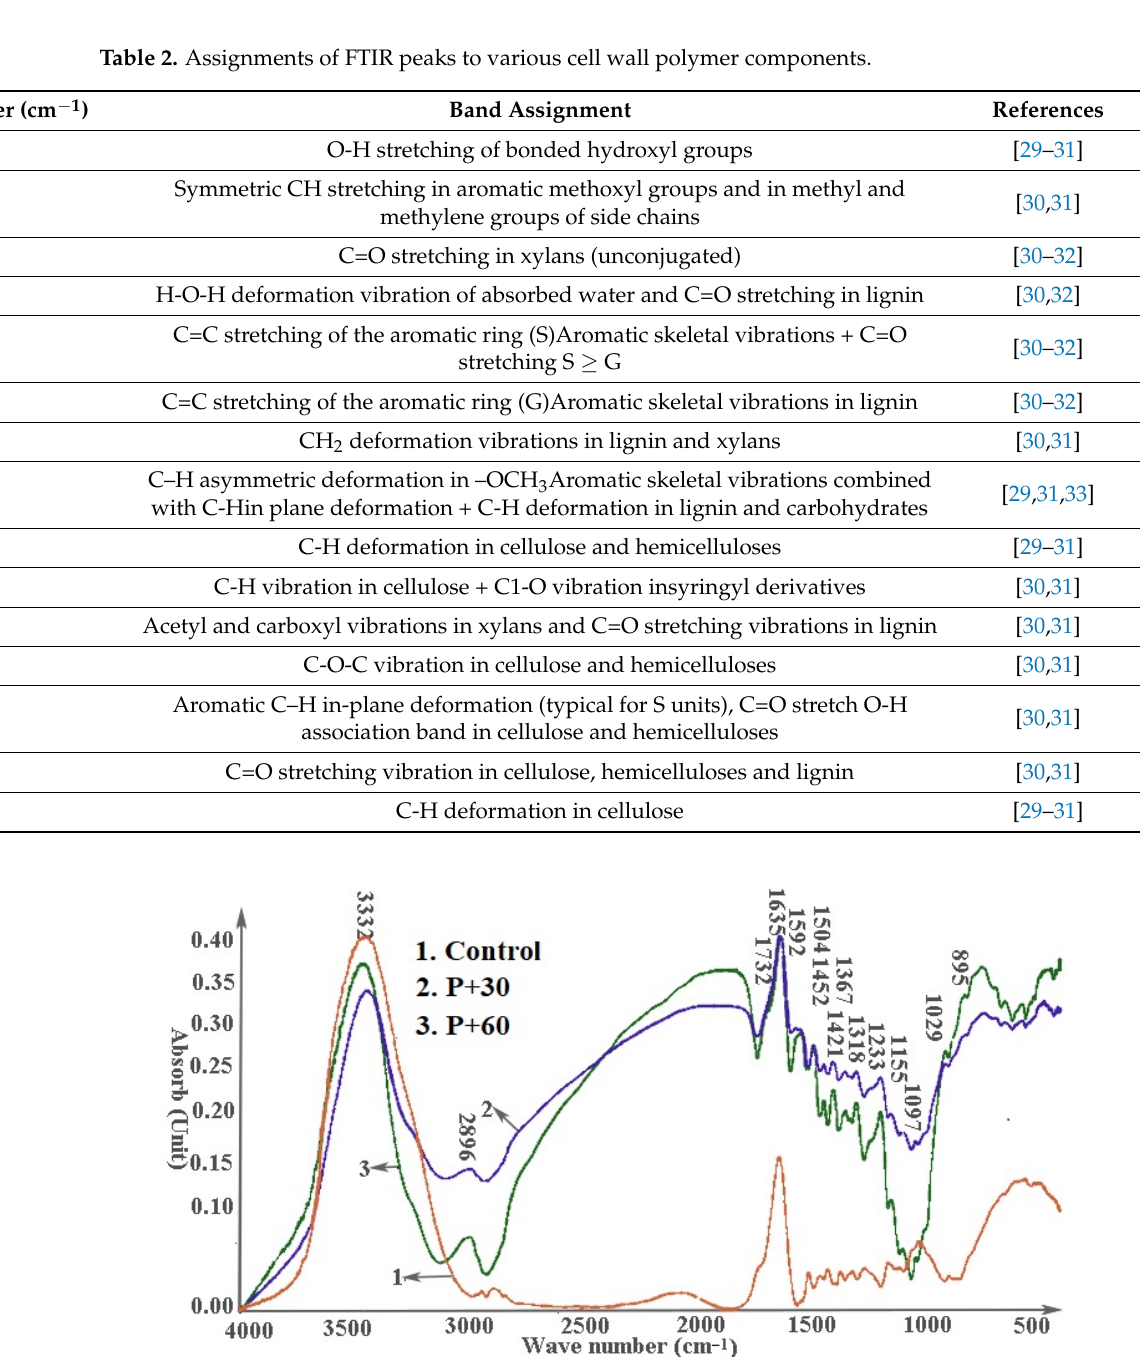
Table 2. Assignments of FTIR peaks to various cell wall polymer components.